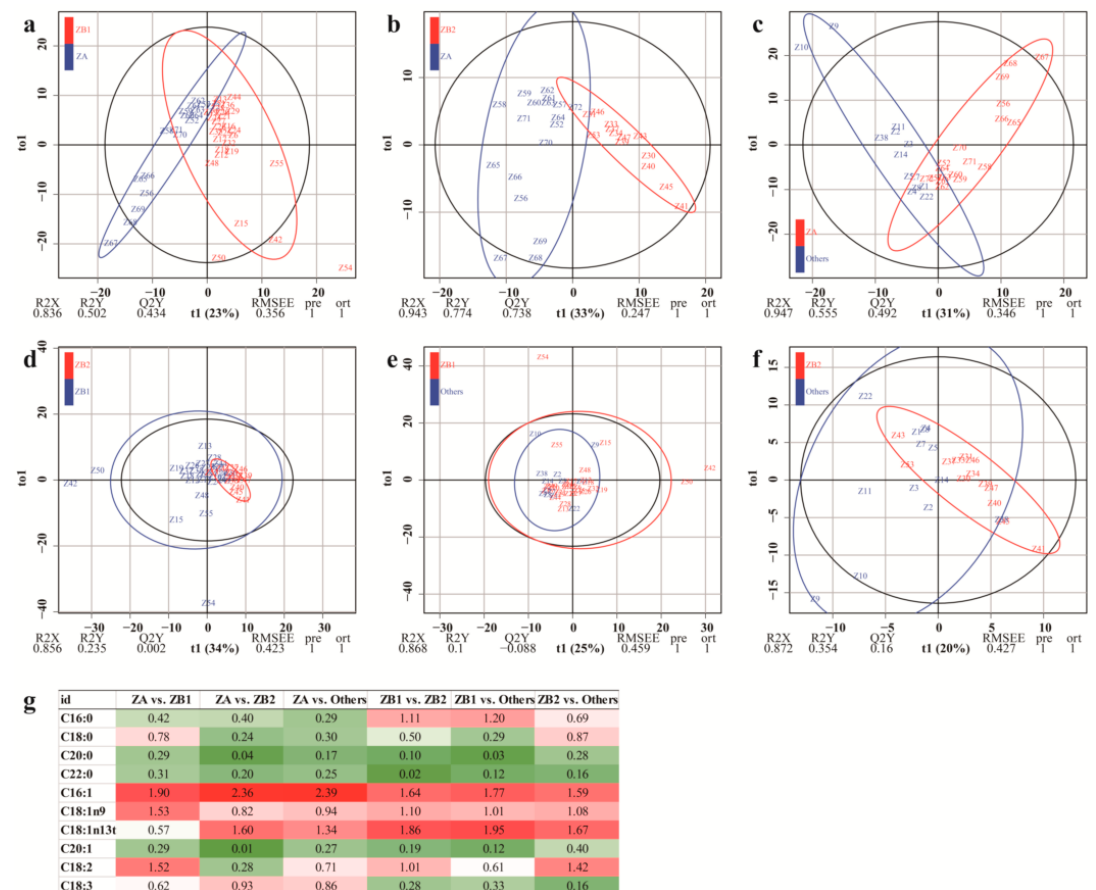
Figure 4. Orthogonal partial least squares discriminant analysis (OPLS-DA) between different Zanthoxylum species: ( a ), OPLS-DA between ZA and ZB1; ( b ), OPLS-DA between ZA and ZB2; ( c ), OPLS-DA between ZA and Others; ( d ), OPLS-DA between ZB1 and ZB2; ( e ), OPLS-DA between ZB1 and Others; ( f ), OPLS-DA between ZB2 and others; ( g ), Variable important in projection based on OPLS-DA between different Zanthoxylum species. ZA is Z. armatum ; ZB1 samples, belonging to Z. bungeanum , are represented by pericarps from Hancheng; ZB2 samples, belonging to Z. bungeanum , are represented by pericarps from Fengxian; Others refers to the rest of the samples whose pericarps are red but do not belong to Z. bungeanum ; C16:0 is palmitic acid; C18:0 is stearic acid; C20:0 is eicosanoic acid; C22:0 is behenic acid; C16:1 is palmitoleic acid; C18:1n9 is oleic acid; C18:1n13t is trans-13-oleic acid; C20:1 is cis-11-eicosenoic acid; C18:2 is linoleic acid; and C18:3 is linolenic acid.